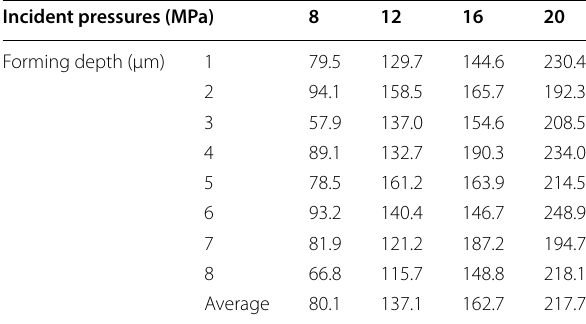
Table 3 Forming depth of bulging parts under different incident pressures